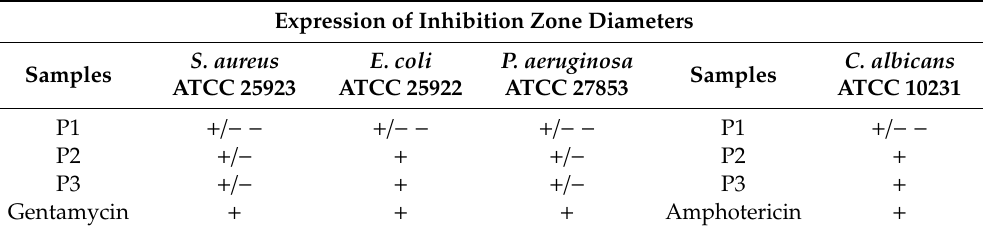
Table 3. Expression of inhibition zone diameters for the tested microbial strains. Expression of Inhibition Zone Diameters E. Samples ATCC 25923